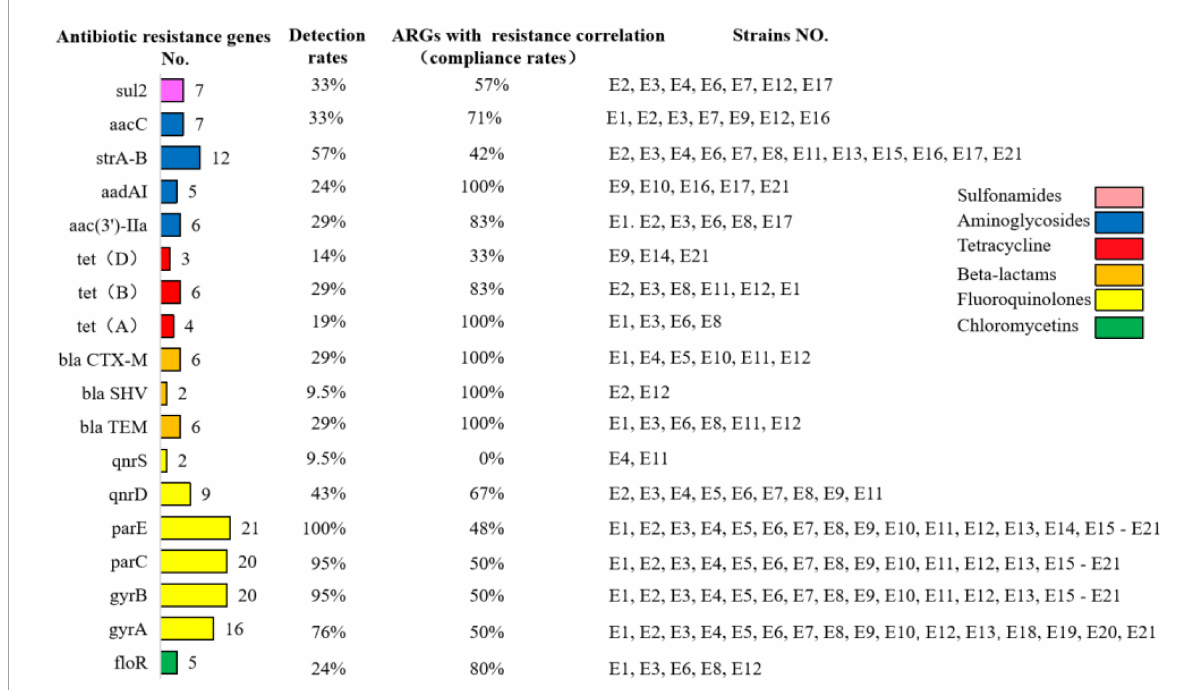
is consistent with the results of resistance studies on E. coli in calves with diarrhea in other countries (Khachatryan et al., 2004). This may be due to the fact that E. coli is